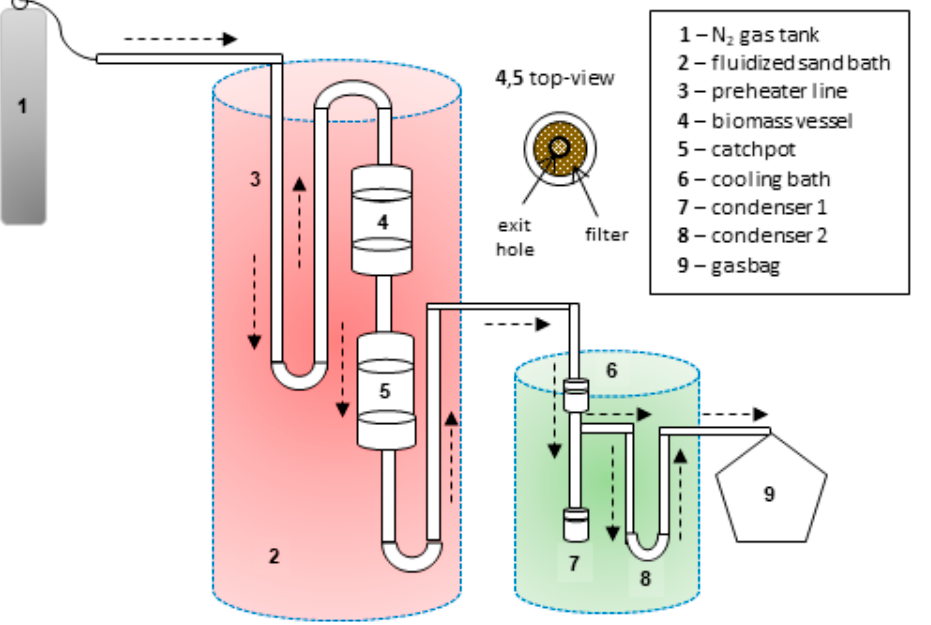
Figure 2. Schematic diagram of the reactor setup for the pyrolysis of pigeon pea wood.